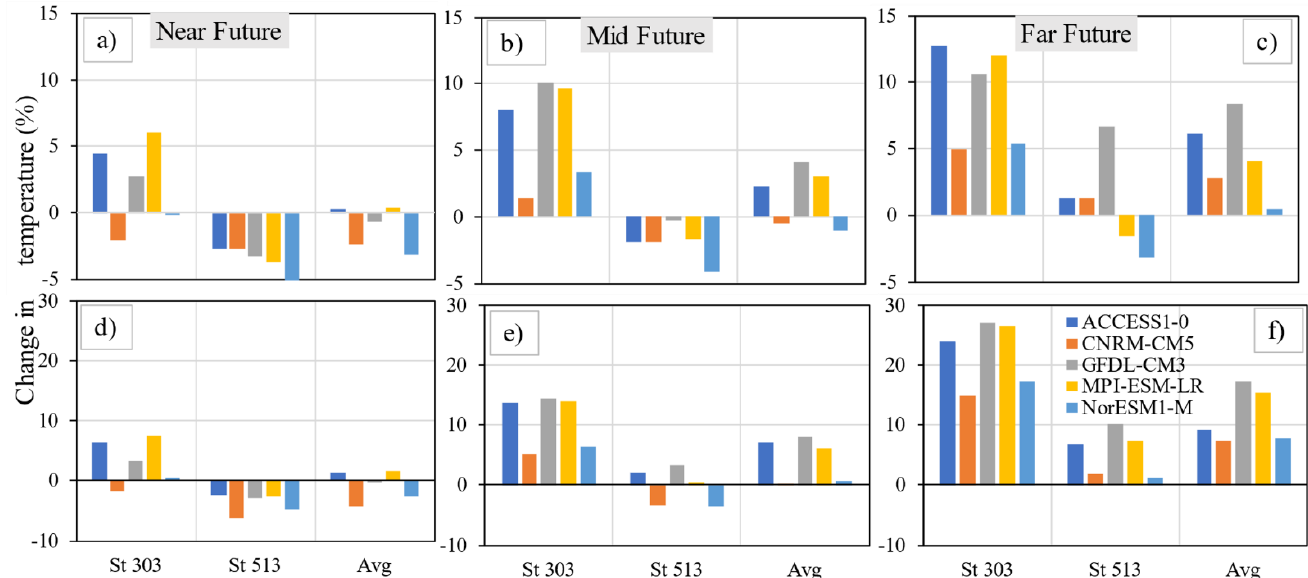
Figure 8. Temporal changes in the maximum temperature for three future time windows, namely, Near Future (2021–2040), Mid Future (2041–2070), and Far Future (2071–2100) using multiple climate models under RCP 4.5 ( a – c ) and RCP 8.5 ( d – f ). ( a – c ) show the percentage change in temperature under the RCP 4.5 emission scenario. ( d – f ) show the same under the RCP 8.5 emission scenario. Additionally, ( a , d ) show the same for the Near Future, ( b , e ) for the Mid Future, and ( c , f ) for the Far Future.